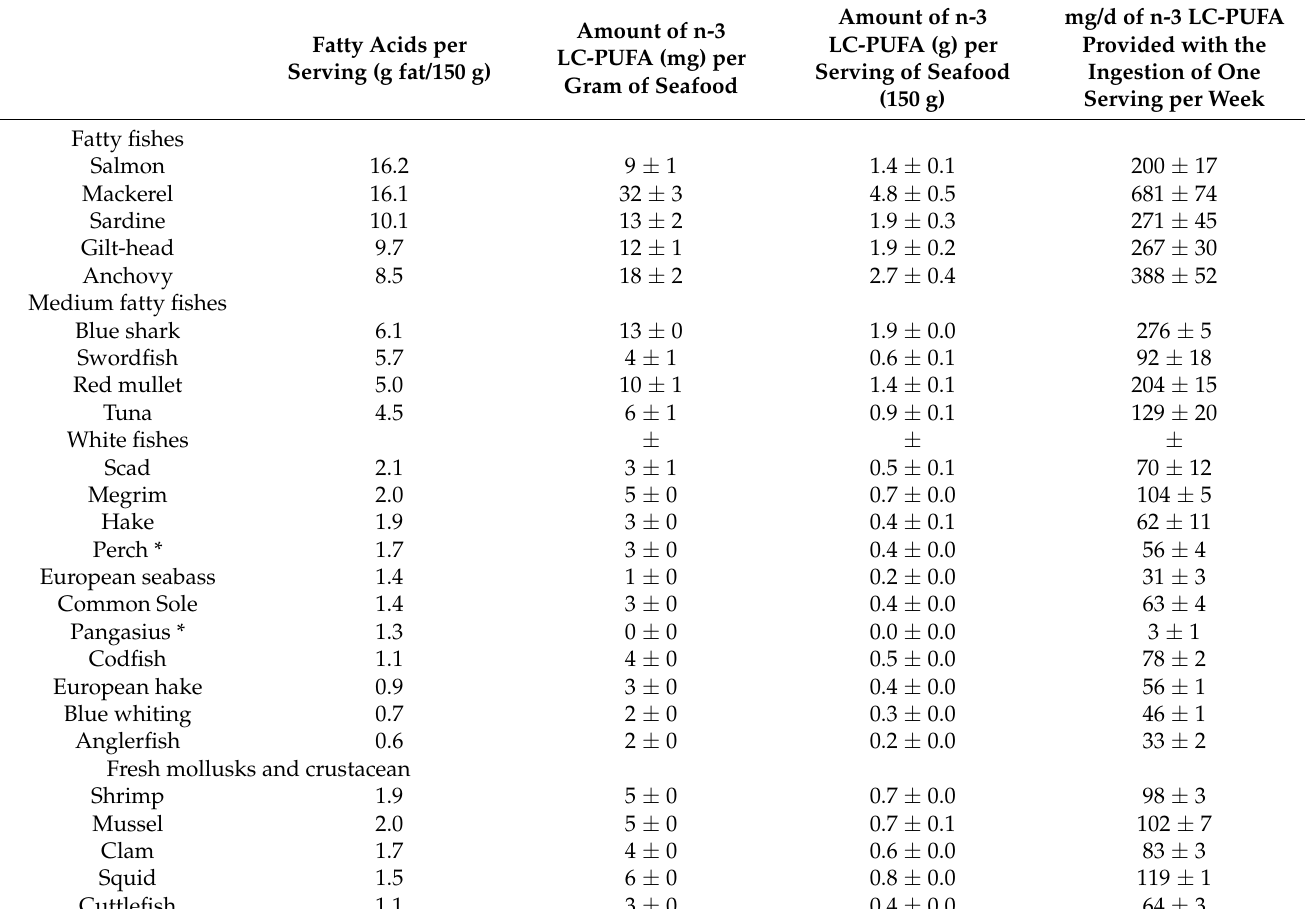
amount of n-3 LC-PUFA (mg/d) provided after the ingestion of one serving per week of fatty, medium fatty, and white fishes, mollusks, and crustaceans. Fatty fishes are the main source of n-3 LC-PUFA per gram or serving, with the most provided by mackerel, anchovy, sardine, gilt-head, and salmon. Blue-shark and red mullet also provide similar amounts to sardine and salmon. With regard to fresh mollusks and crustaceans, squid provides the highest amount of n-3 LC-PUFA (Table 5). Table 5. Estimation of the amount of n-3 provided per gram of seafood, per serving (150 g) and per day after ingestion of one serving of fatty, medium fatty, and white fresh fishes, mollusks and crustaceans that are typically consumed in Spain. mg/d of n-3 LC-PUFA Amount of n-3 Amount of n-3 Provided with the LC-PUFA (g) per Fatty Acids per LC-PUFA (mg) per Ingestion of One Serving of Seafood Serving (g fat/150 g) Gram of Seafood Serving per Week (150 g) 16.2